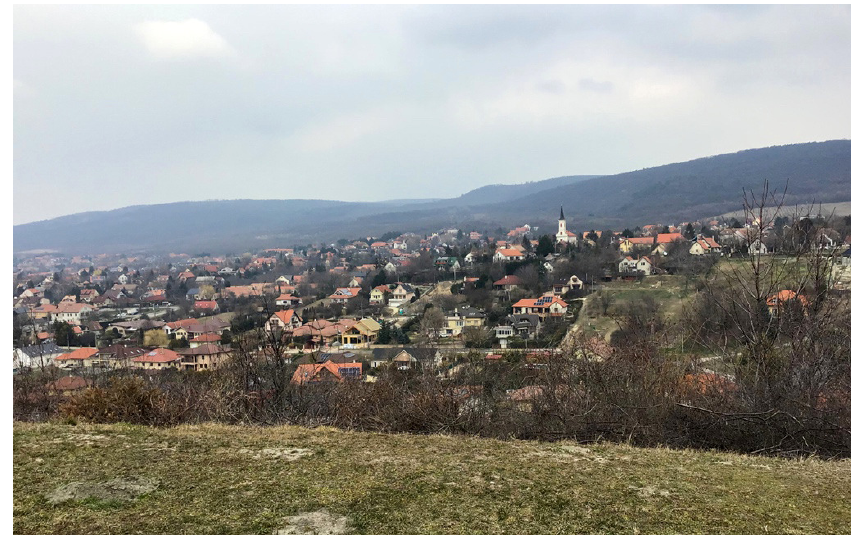
Figure 4. Telki and surroundings. Source: Photo by M. Bagyura.